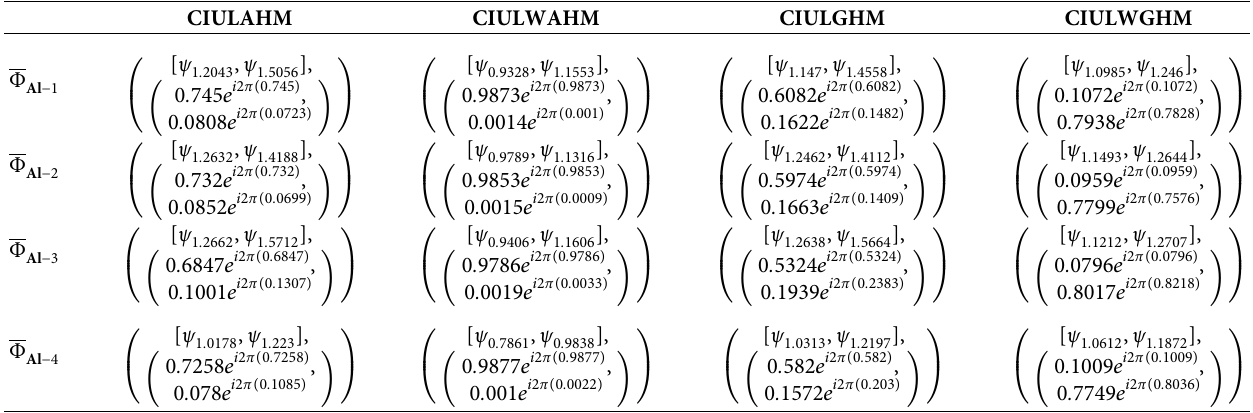
Table 5: Aggregated values of the alternatives by CIULAHM, CIULWAHM, CIULGHM, and CIULWGHM operators.